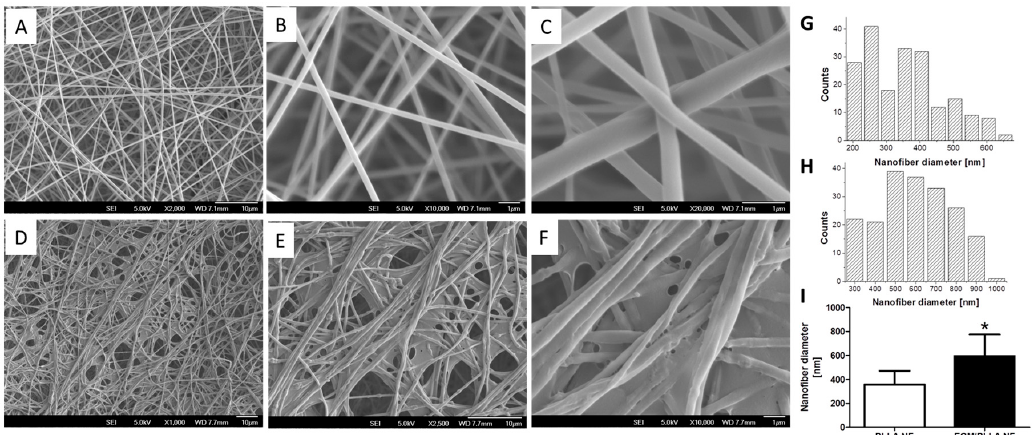
Figure 1. PLLA electrospun nanofibers before and after ECM decoration: ( A ) Electrospun PLLA Nanofibers, low mag; ( B ) Electrospun PLLA Nanofibers, medium mag; ( C ) Electrospun PLLA Nanofibers, high mag; ( D ) Electrospun PLLA Nanofibers decorated with ECM, low mag; ( E ) Electrospun PLLA Nanofibers decorated with ECM, medium mag; ( F ) Electrospun PLLA Nanofibers decorated with ECM, high mag; ( G ) Histogram of PLLA NF diameter; ( H ) Histogram of ECM/PLLA NF diameter; ( I ) Average diameter comparison between PLLA and ECM/PLLA, * indicates significant difference ( p <